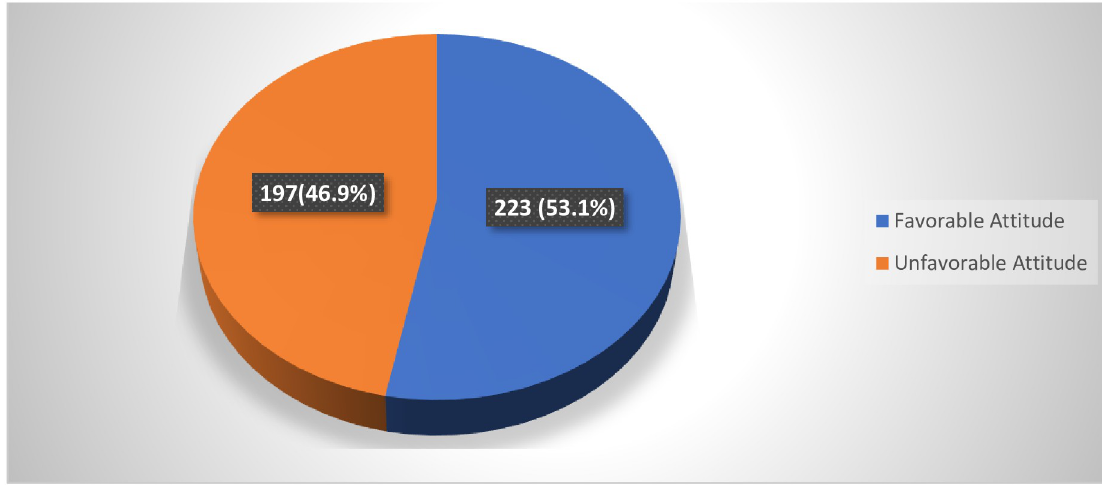
Fig 1. Attitude of community towards mental health problems.